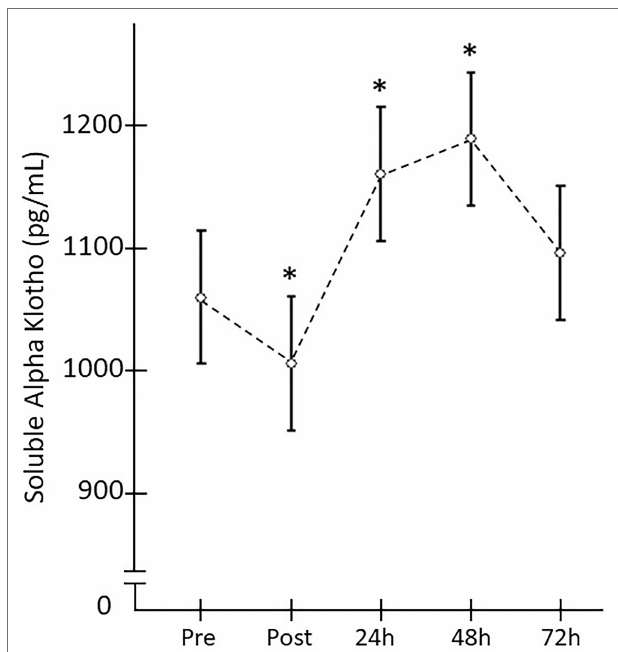
FIGURE 4 | Plasma S α KI levels monitored after the strength exercise intervention. * Significant difference vs. baseline ( p <